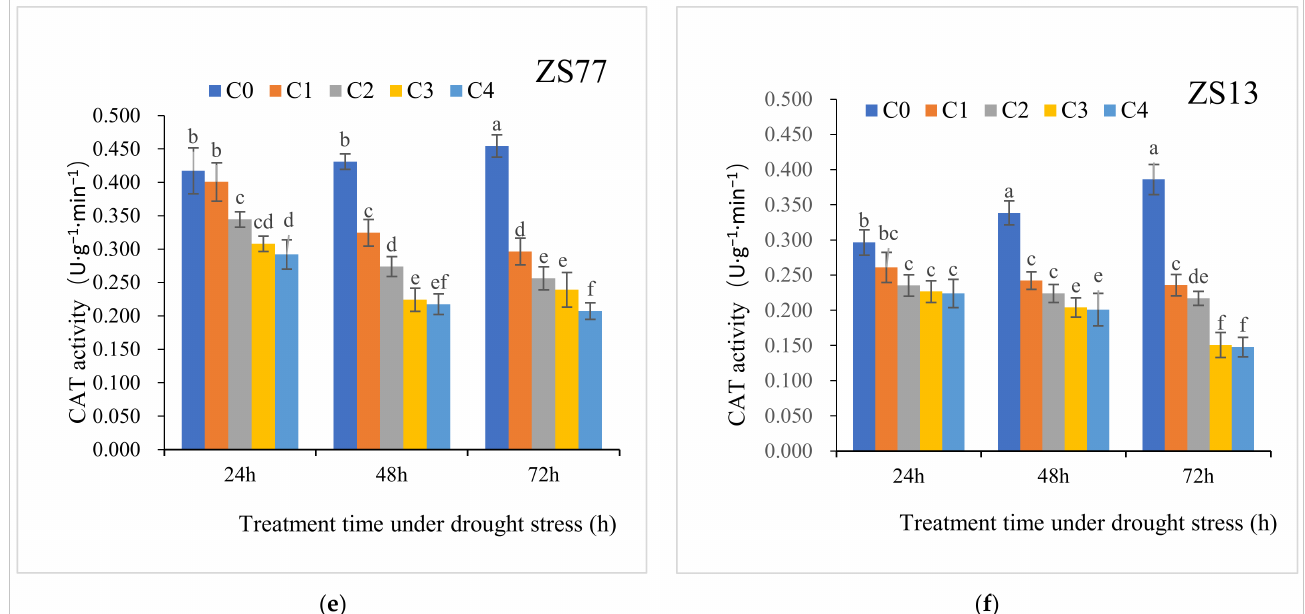
Figure 5. Effect of different concentrations of exogenous SA solution 0 (C0), 1.00 (C1), 2.00 (C2), 4.00 (C3), and 8.00 mg · L − 1 (C4) on SOD ( a , b ), POD ( c , d ), CAT ( e , f ) activities in sweet-potato leaves under drought stress. Bars with different letters indicate significant differences among treatments at 0.05 level